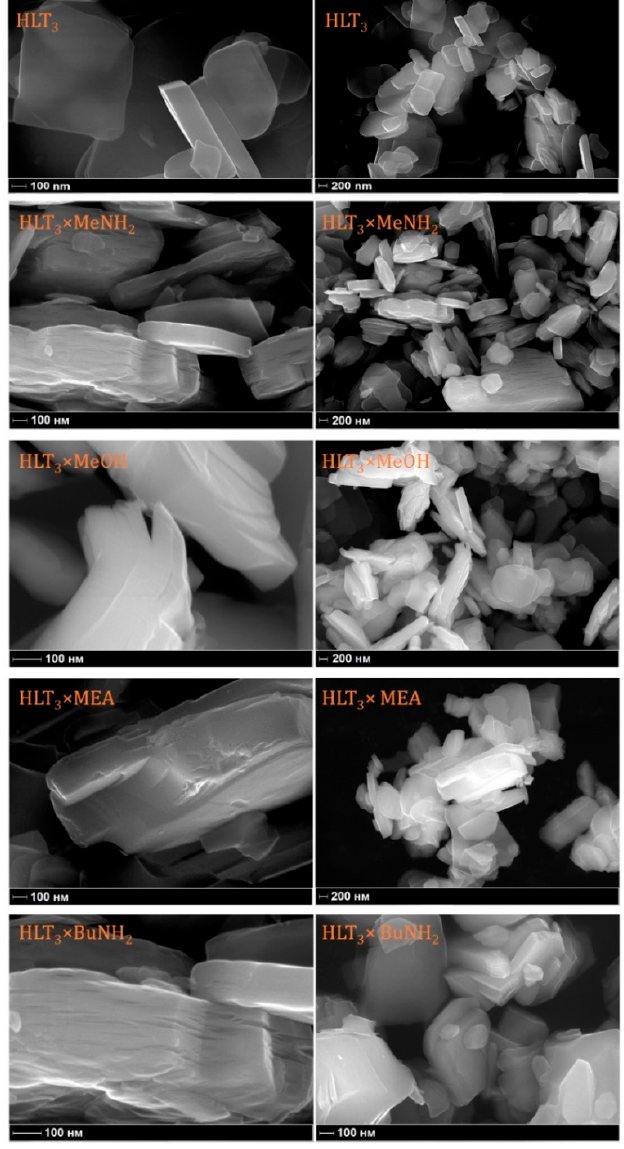
Figure 4. SEM images of the initial HLT 3 and organic-inorganic HLT 3 × MeOH, HLT 3 × MeNH 2 , HLT 3 × MEA, and HLT 3 × BuNH 2 compounds.